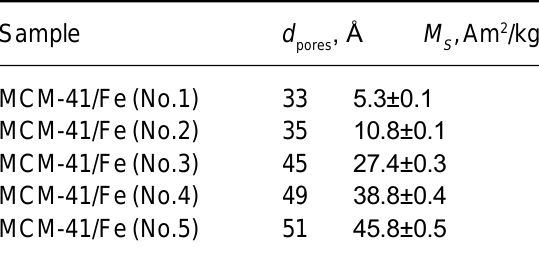
Table 6. Magnetic properties of the studied nanocomposites MCM-41/Fe.